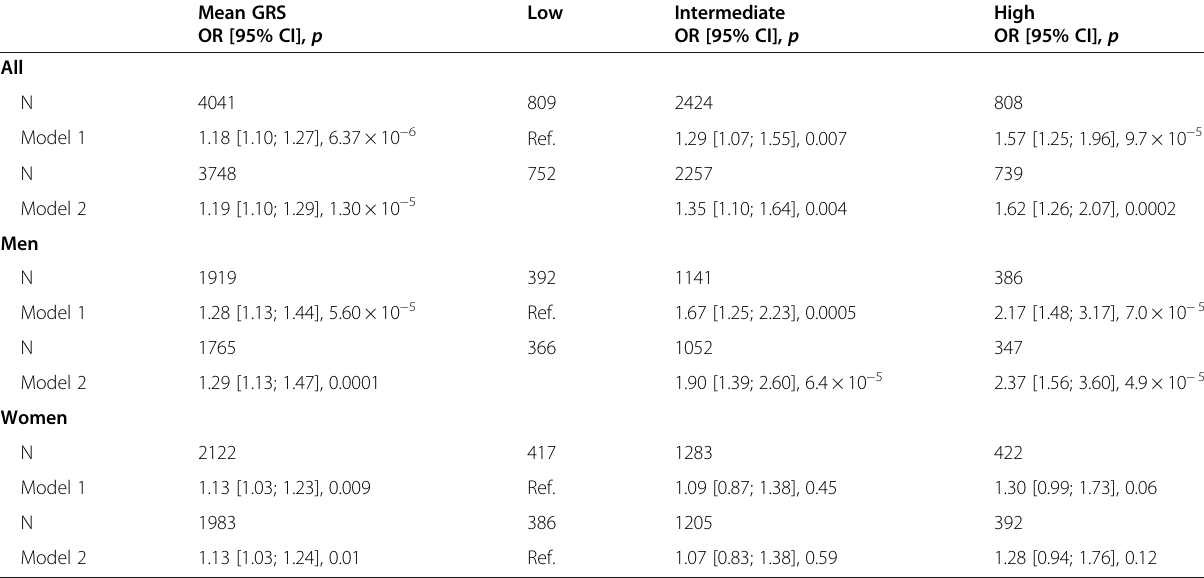
Table 2 Association of coronary artery disease genetic risk score with coronary artery calcification in the Heinz Nixdorf Recall study